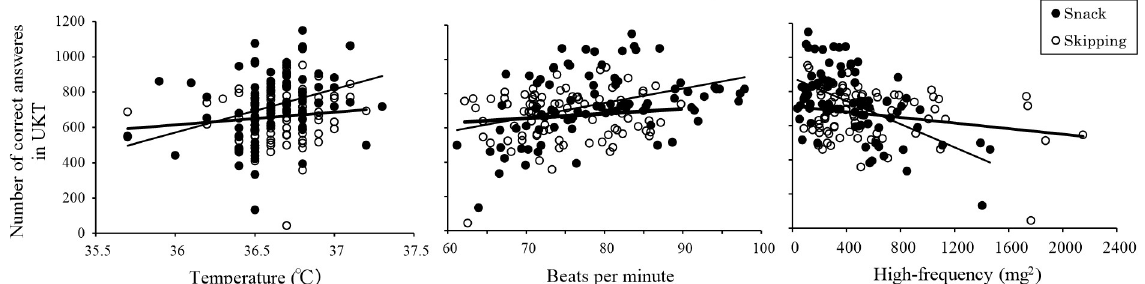
Fig 6. Scatterplots for change on the Uchida-Kraepelin Test after eating (04:00 to 09:00) compared to temperature (left panel), heart rate (center panel), and high-frequency after eating (right panel). Trend lines are shown for each condition (Snack: black circles, solid lines; Skipping: white circles, dashed